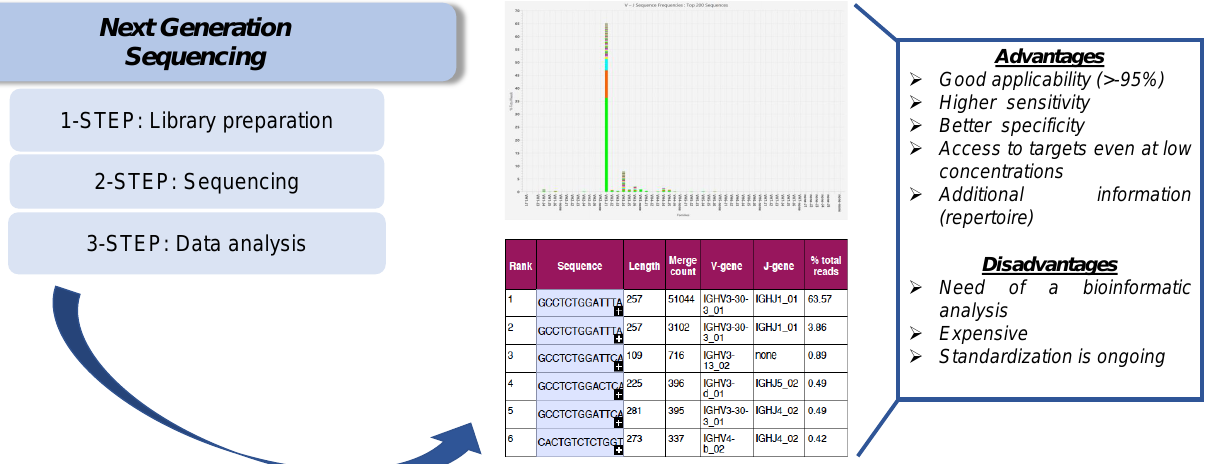
Figure 2. NGS analysis. A library is prepared by fragmentation and conjugation with Figure 2 . NGS analysis . A library is prepared by fragmentation and conjugation with adaptive sequences, composed with few nucleotides ( 1-step ) and subsequently it is amplified and sequenced, with the production of so-called ≪ reads ≫ ( 2-step ). Data analysis is performed through the use of bioinformatic tools , matching the results to a reference genome ( 3-step ).